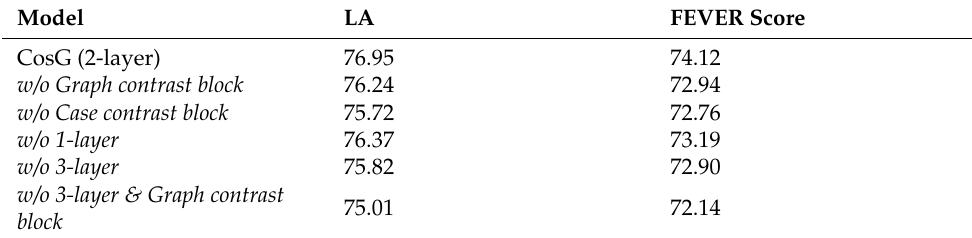
Table 5. Results of an ablation study on development set